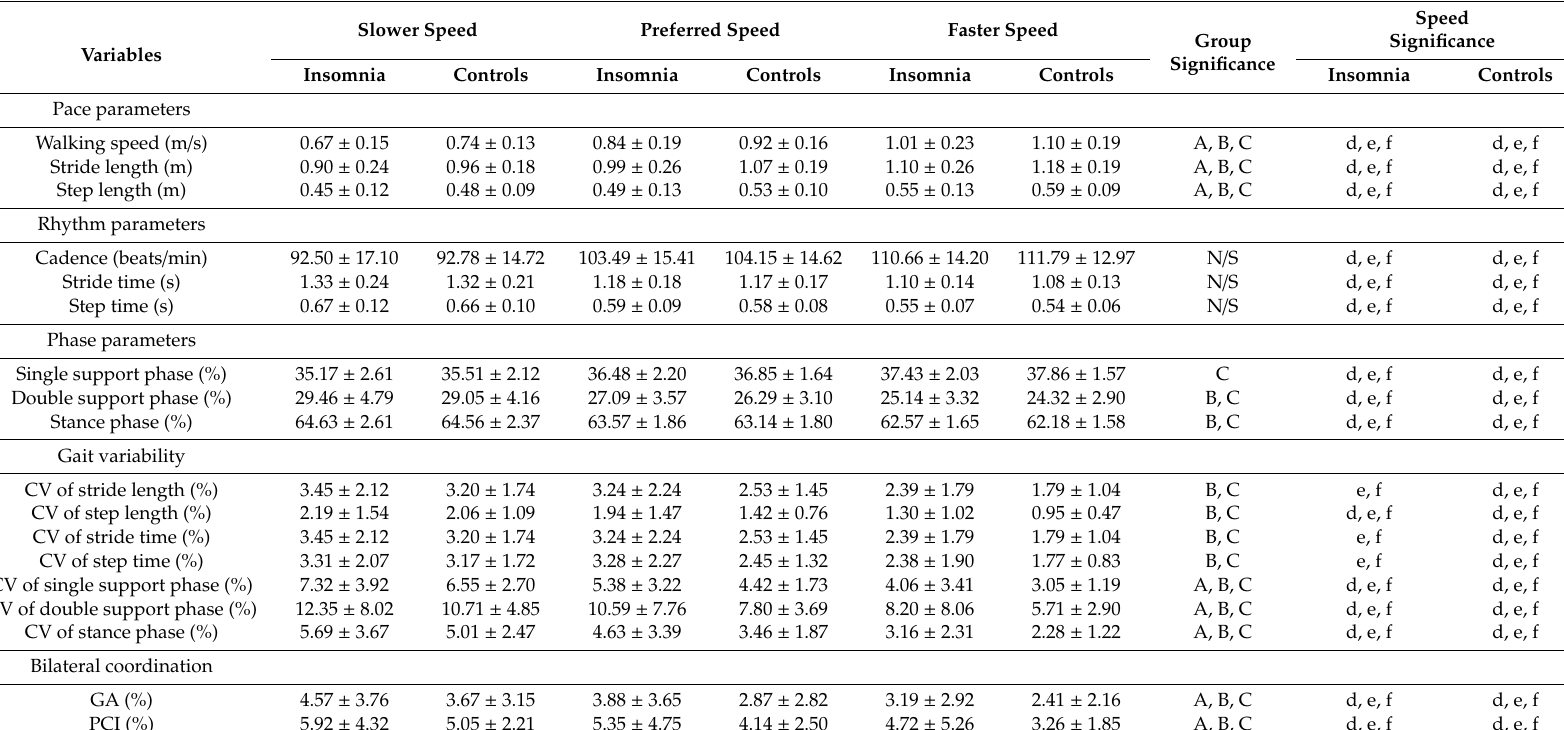
Table 3. Di ff erences in gait variables in insomnia and control groups at di ff erent